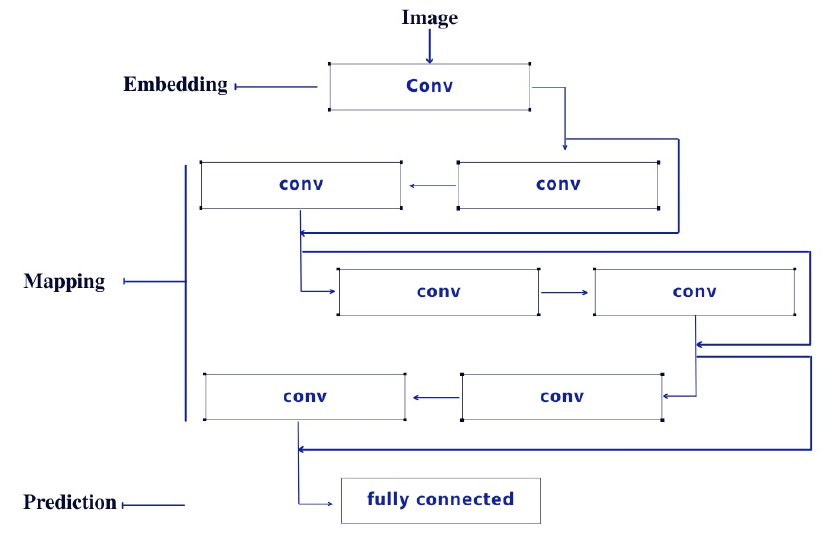
Figure 11. The basic building block of a ResNet.